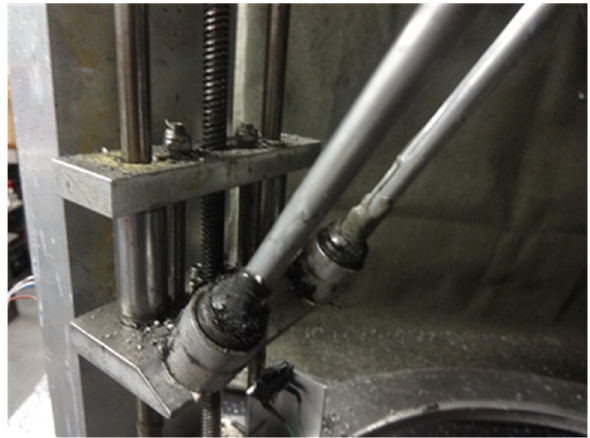
Figure 2. Detail of carriage assembly and magnetic ball joint with sleeves on the open source metal RepRap 3-D printer. The lead screw from the stepper motor driving that carriage is also visible in the center of the